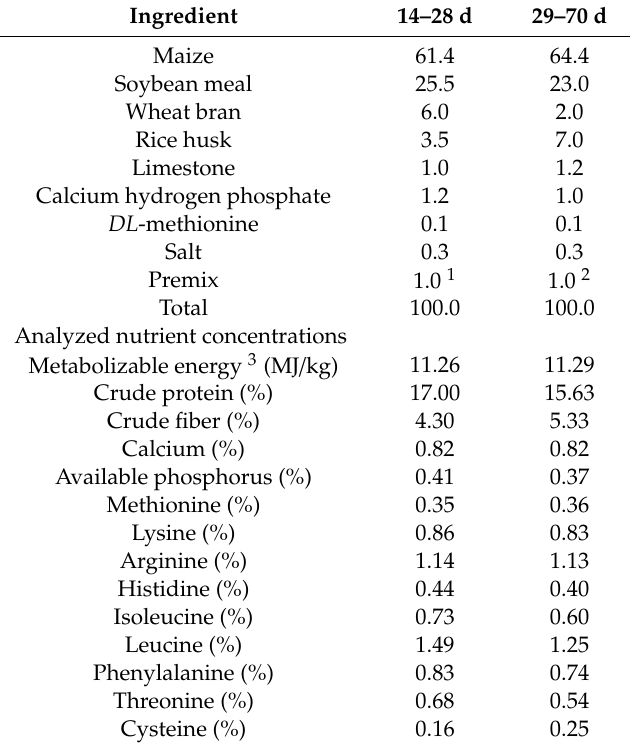
Table 1. Composition and nutrient levels of the basal